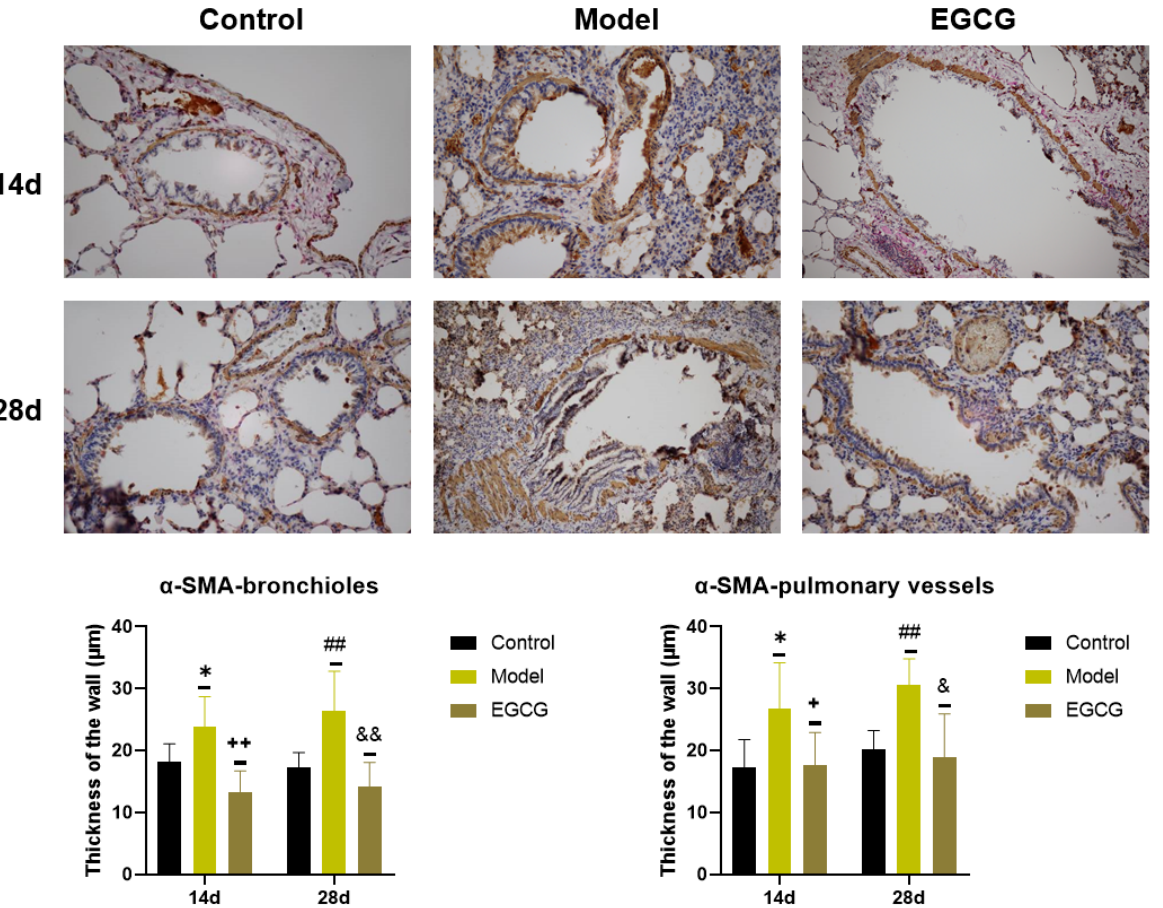
Figure 5. Immunohistochemical determination of the smooth muscle mass presence in the lungs of saline-instilled animals (Control), silica-instilled non-treated animals (Model), and EGCG-treated silica-instilled animals (EGCG) after 14 days (14d) or 28 days (28d) of the treatment delivery. Presence of smooth muscle mass was verified by using antibody against α -smooth muscle actin (SMA) and was expressed as a thickness of the walls of bronchioli and pulmonary vessels (in µ m). For statistical differences among the groups: * p < 0.05 for Model14d vs. Control14d; + p < 0.05 and ++ p < 0.01 for EGCG14d vs. Model14d; ## p < 0.01 for Model28d vs. Control28d; & p < 0.05 and && p < 0.01 for EGCG28d vs. Model28d.